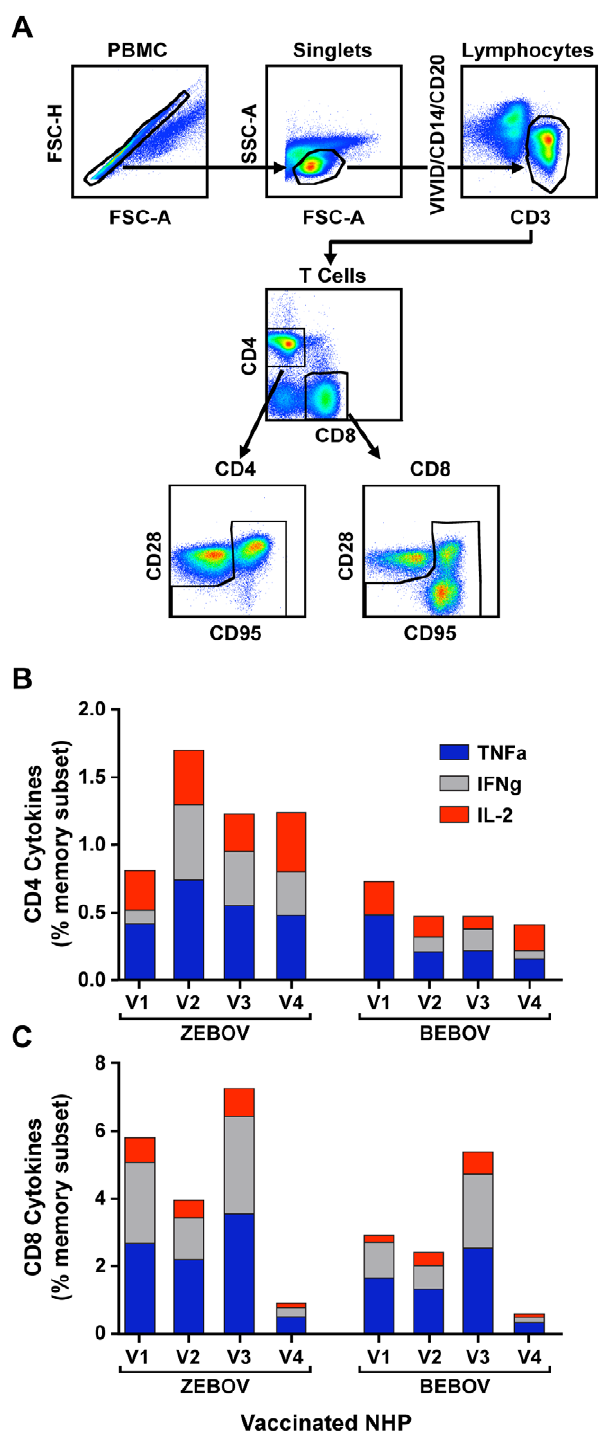
Figure 3. T-cell immune responses measured by intracellular cytokine staining. PBMC were stimulated with overlapping peptides spanning the GP protein, and antigen-specific CD4 + and CD8 + cells were enumerated in the memory cell gates (A) by the detection of cytokine production. The percentages of cytokine- positive CD4 + (panel B) and CD8 + (panel C) T cell memory cells specific for ZEBOV (blue) and BEBOV (red) were determined at 4 weeks post rAd-GP boost. Responses are shown for each individual cytokine measured as the total proportion of cells positive for TNF a (blue), IFN c (gray), IL-2 (red), expressed as a percentage of